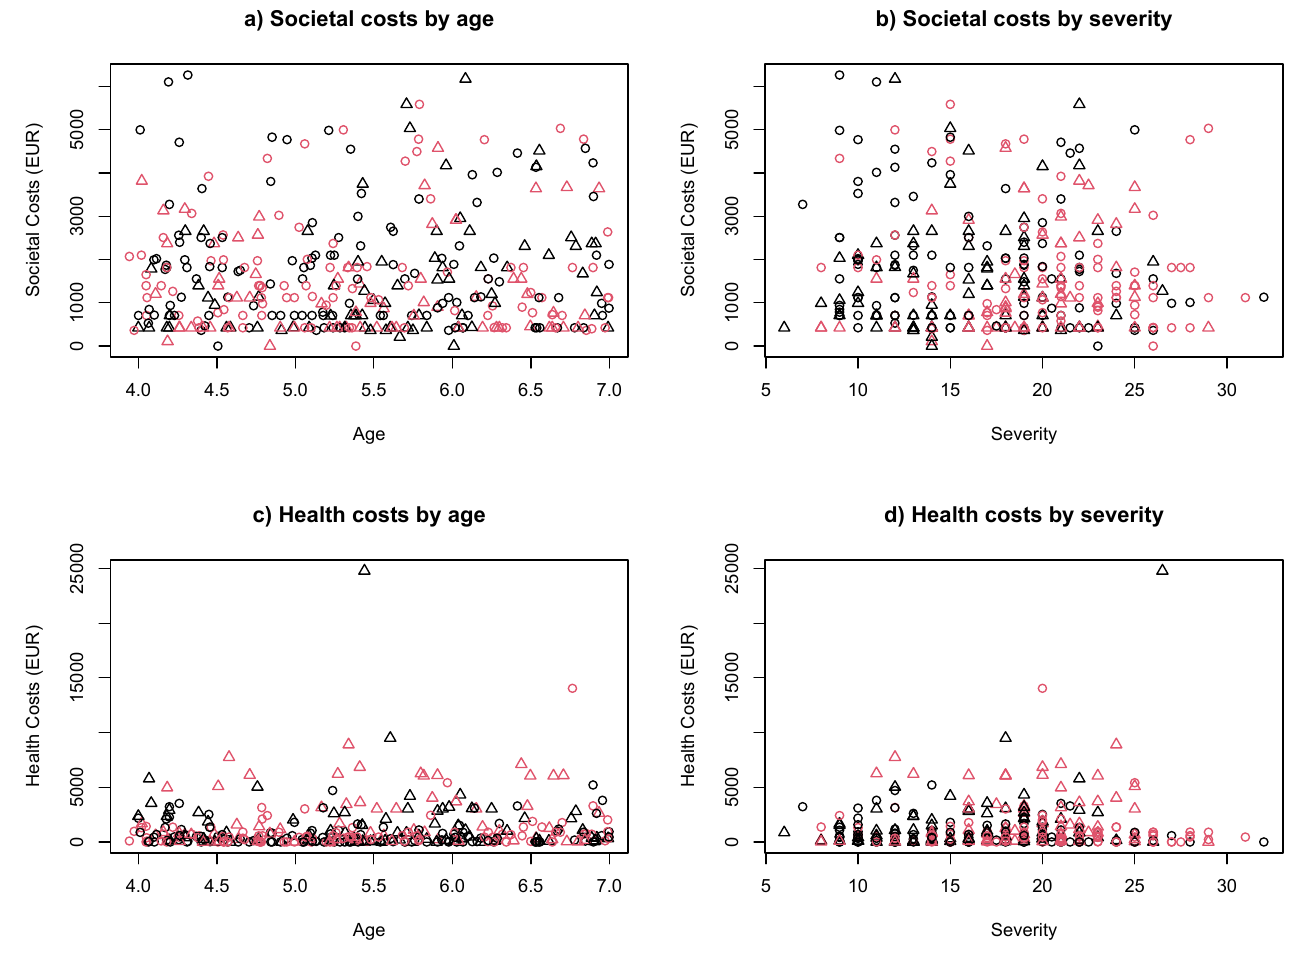
Figure 1. Results of regression analyses. ( a ) Societal costs by age; ( b ) Societal costs by severity; ( c ) Health costs by age; ( d ) Health costs by severity. Severity was measured using ADOS Total scores (adapted as described in Bieleninik [32]. Red—intellectual disability; black—no intellectual disability or unknown (8 cases). Circle—in Europe (including Israel); triangle—outside Europe.